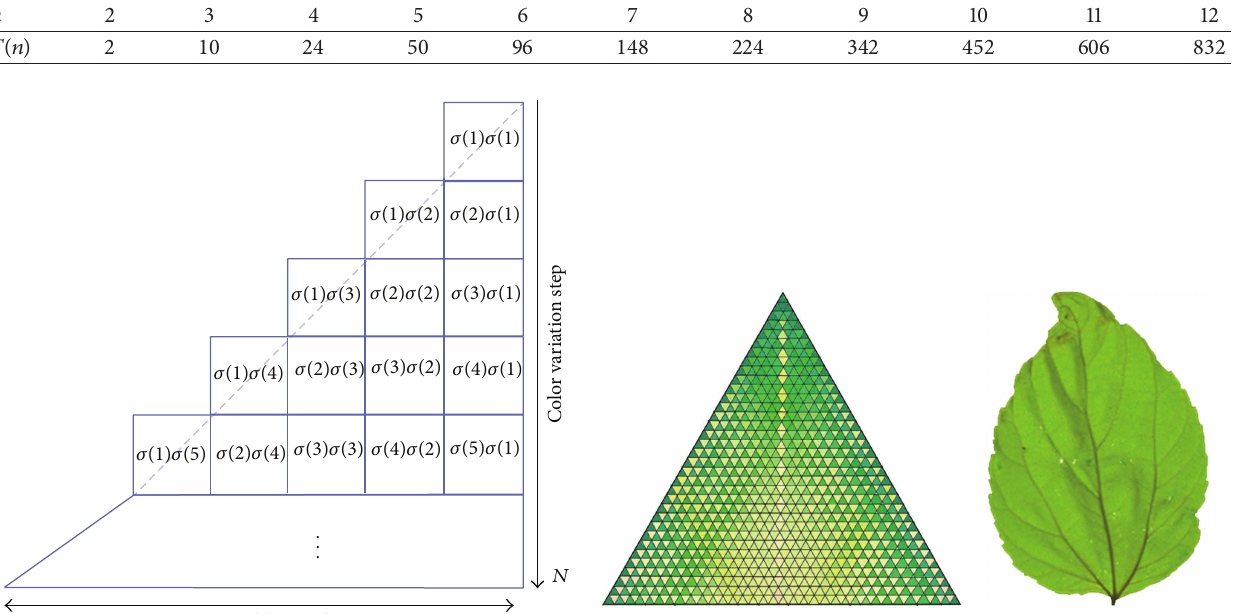
Figure 2: Color of leaves.